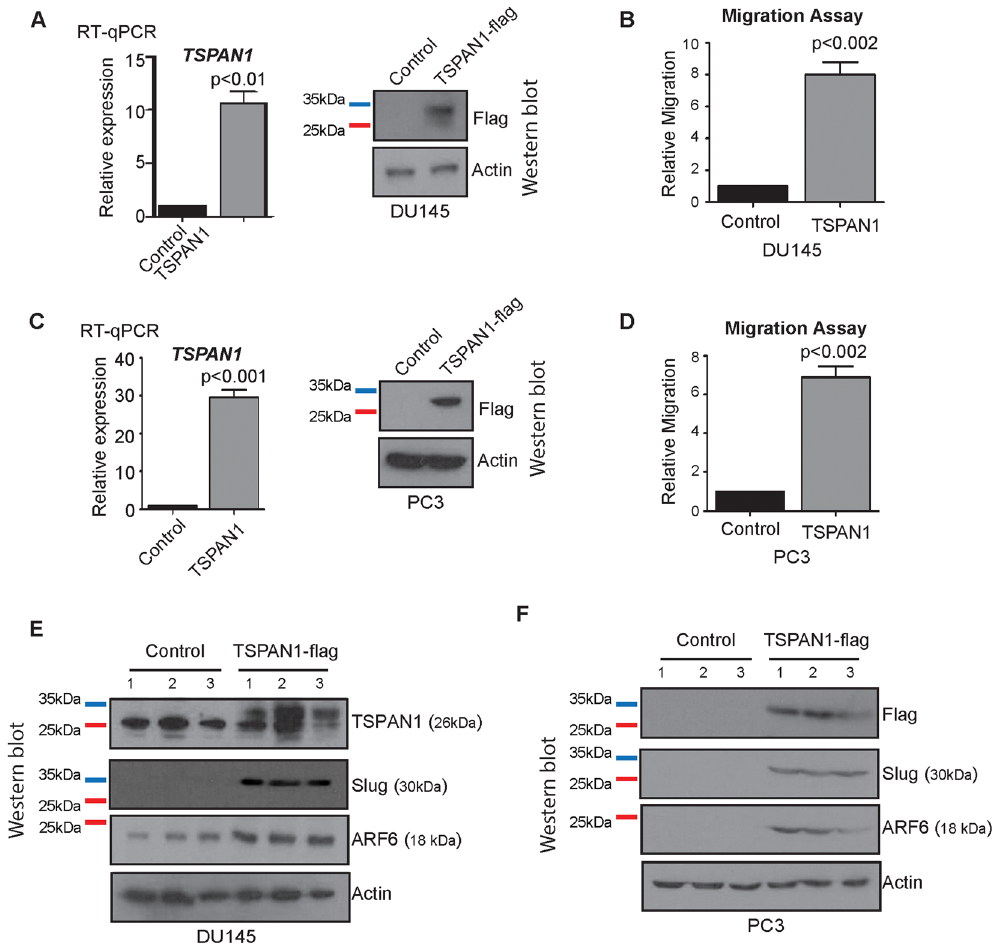
Figure 3. TSPAN1 increases prostate cancer cell migration and induces the expression of Slug and ARF6. ( A,C ) Validation of TSPAN1 overexpression in DU145 and PC3 cells by real-time PCR and western blot. (B,D) Migration assays for DU145 and PC3 cells overexpressing TSPAN1. (E,F) Western blot analysis of Slug and ARF6 protein expression in DU145 and PC3 cells overexpressing TSPAN1. Please note: cropped western blots are displayed in the figure, but full length blots are included in the Supplementary Information